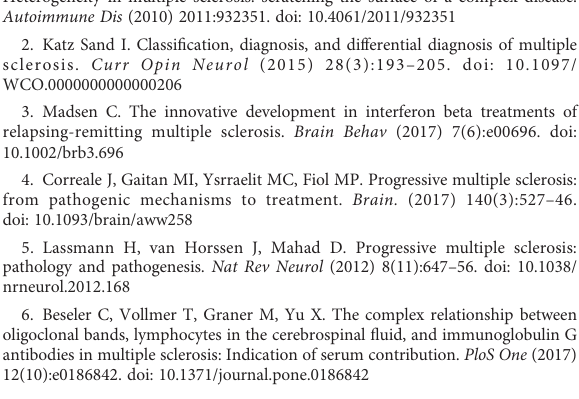
SUPPLEMENTARY FIGURE 2 Colocalization of C5b-9 and NeuN in the spinal cord of TMEV-IDD and rEAE mice. TMEV-IDD and rEAE mice were necropsied at ~120 dpi (chronic stage) and ~15 dpimm (acute relapse), respectively. Spinal cords were harvested for immunohistochemical analyses of the late complement component C5b-9 and the neuronal marker NeuN. In both (A) rEAE and (B) TMEV-IDD mice, we found that C5b-9 (green) does not colocalize with NeuN (red), suggesting that, in these mice, there is no triggering of the cytotoxic component of the complement system. Images are representative of 3 to 4 mice per group. Representative z stacks are shown and the scale